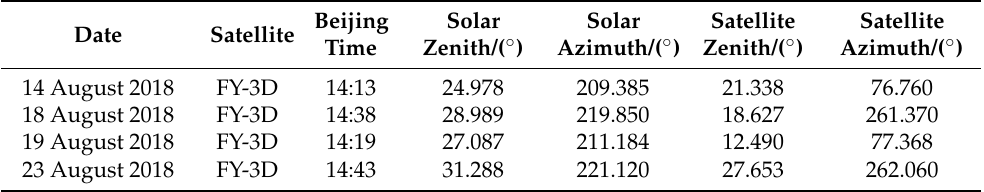
Table 1. Geometric parameters during satellite overpass.